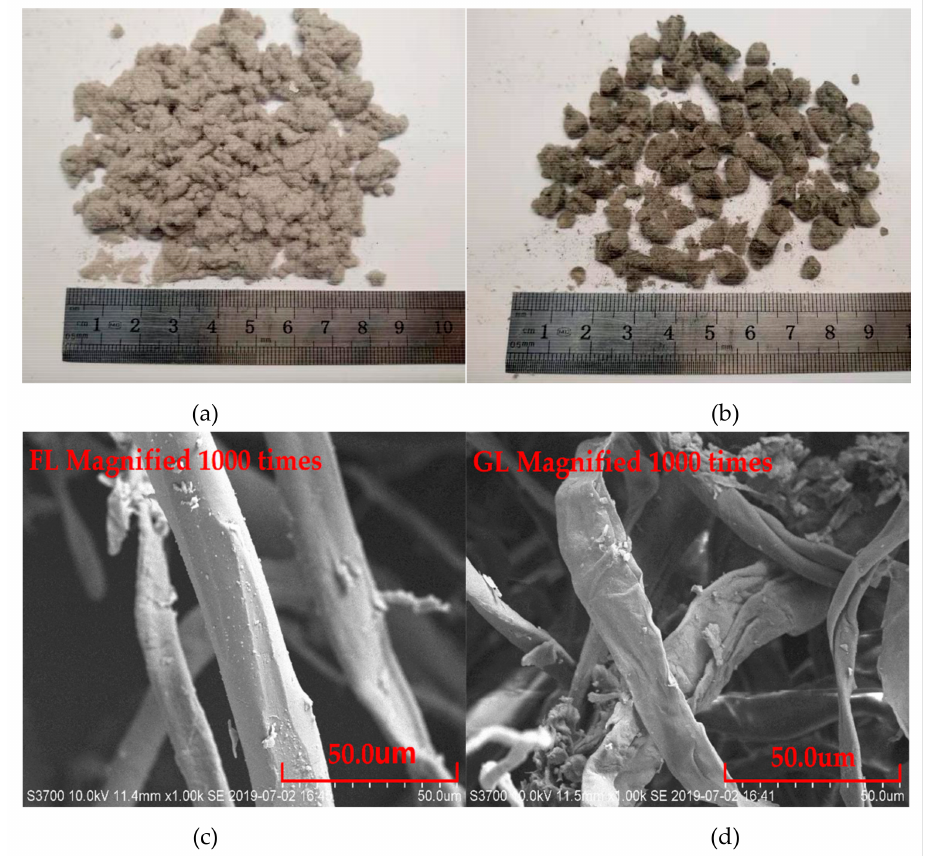
Figure 1. Lignocellulosic modifiers: ( a ) flocculent lignocellulose (FL) and ( b ) granulated lignocellulose (GL); ( c ) SEM of FL and ( d ) SEM of